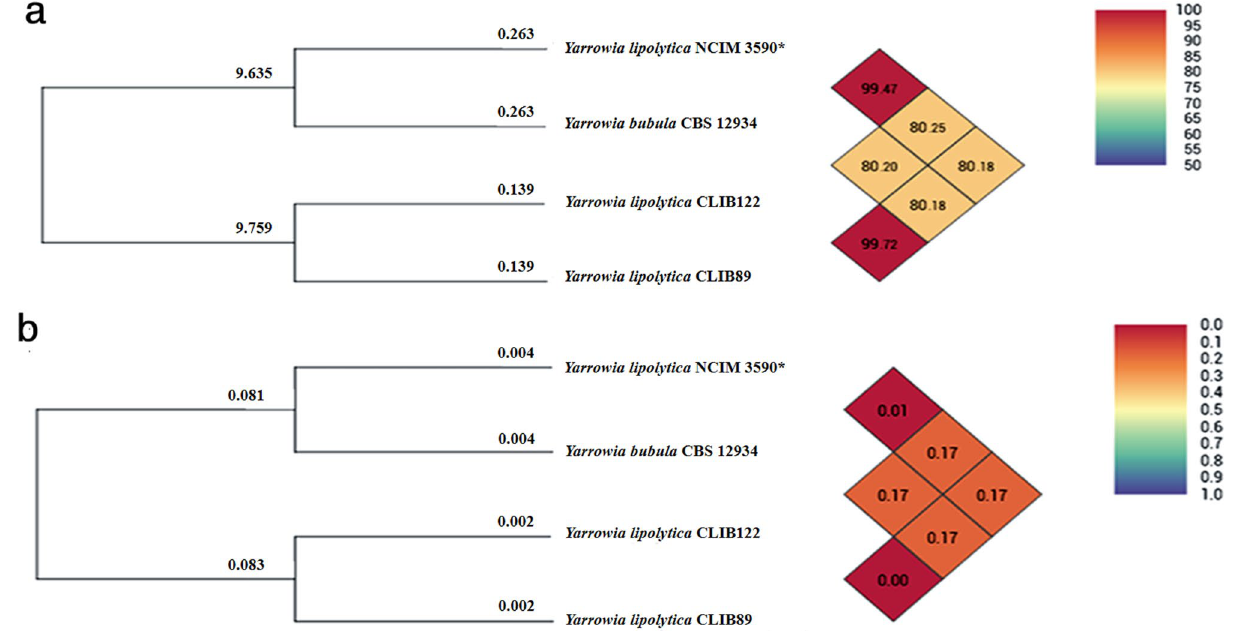
Figure 2. Dendrogram of the inter-species genomic relatedness for four Yarrowia s trains. Heat map generated using ( a ) Overall orthologous average nucleotide identity values (OrthoANI) and ( b ) GGDC distance among Yarrowia genomes was calculated using Orthologous Average Nucleotide Identity Tool (OAT) software version 0.90 Y. lipolytica CLIB 122 (GenBank accession GCA_000002525.1), Y. lipolytica CLIB 89 (W29) (GenBank accession GCA_001761485.1), NCIM 3590 (GenBank accession GCA_003571375.1) and Y. bubula CBS 12934 (GenBank accession GCA_900519075.1) . Values in color matrix boxes indicate the similarity percentage among the